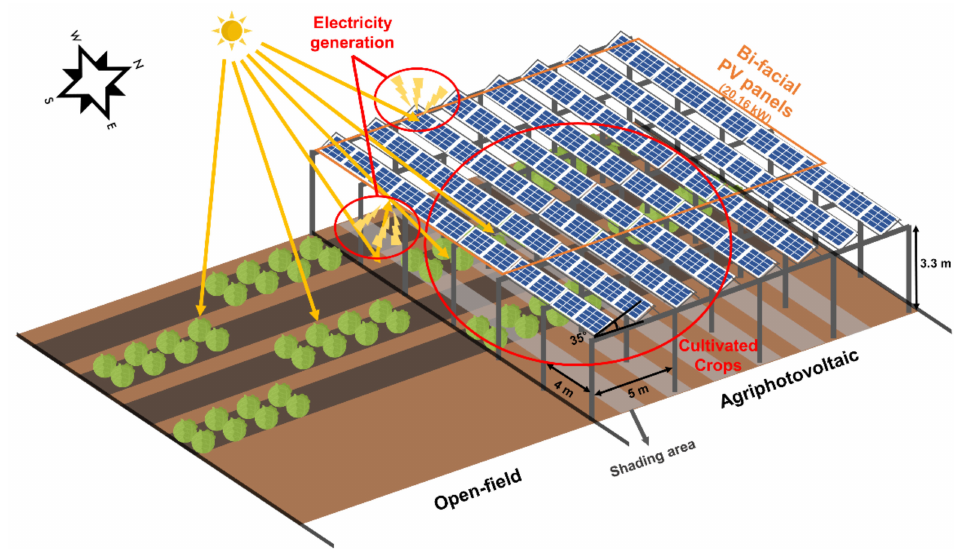
Figure 1. The conceptual diagram of agriphotovoltaic (APV) setup. Bi-facial photovoltaic (PV) panels generate power and crops are cultivated under the PV panels. The shading areas exist owing to sunlight blocked by PV